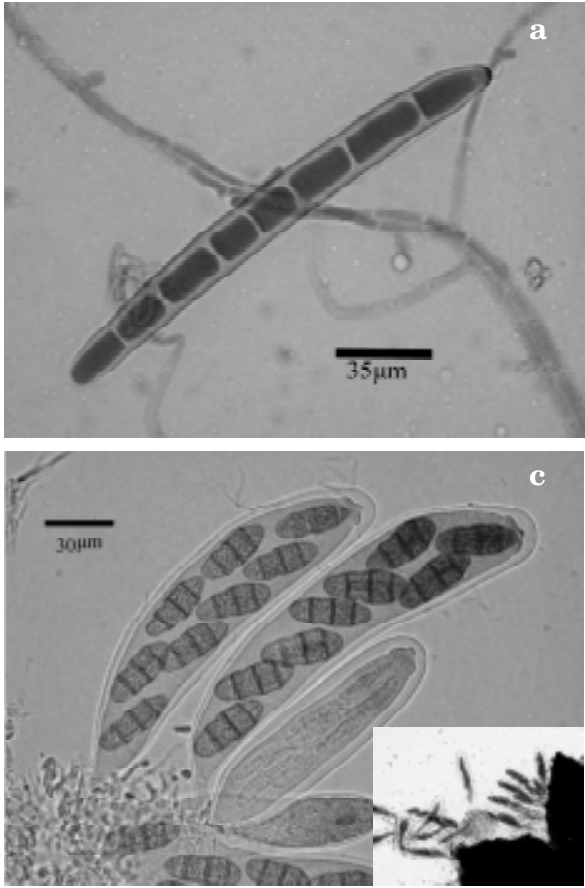
Fig. 1. Structures of the fungus causing tan spot of wheat in Syria. a. Conidium with conidiophore; b. leaf fragment with fruiting bodies; c. erupted pseudothecium with asci and ascospores; d. ascopspore; e. symptoms of tan spot on artificially inoculated wheat cultivar